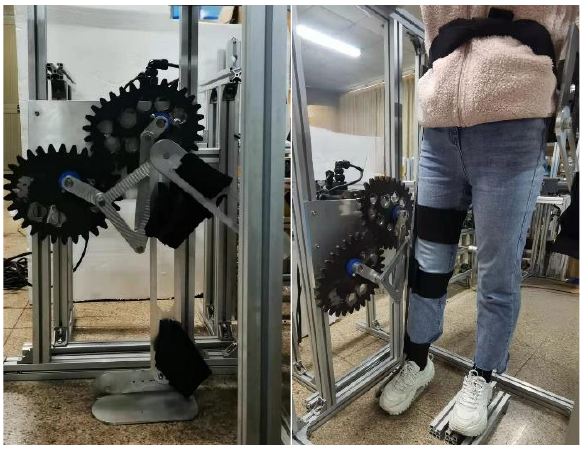
Figure 18. Layout of test bench.